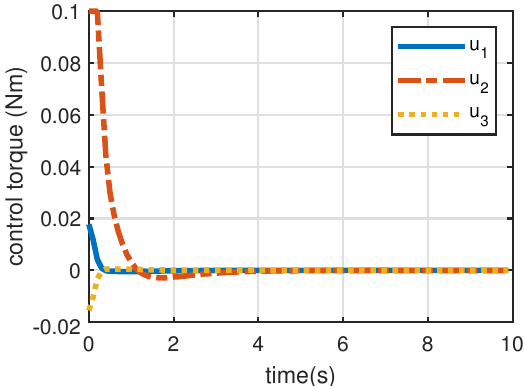
Figure 11. The time histories of control